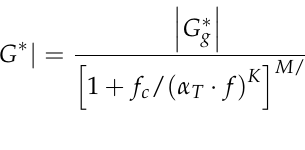
Figure 5. Preparation of DSR test samples ( a – d ).